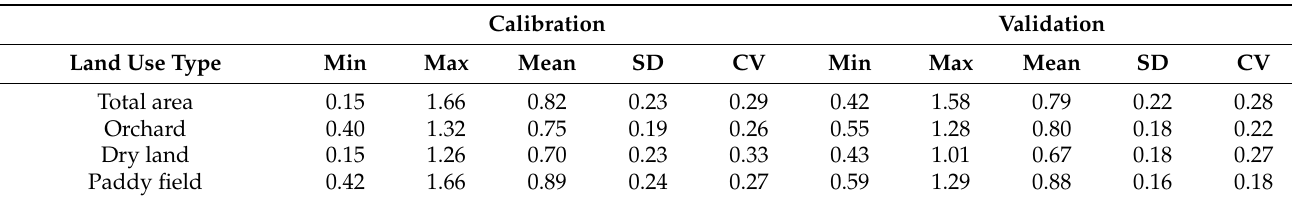
Table A4. The statistics of SOC (%) of calibration and validation data sets under total area, orchard, dry land, and paddy field.